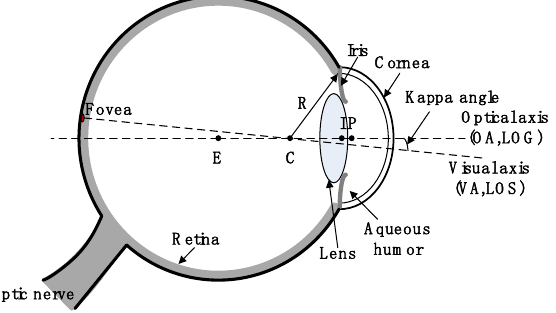
Figure 9. Human eyeball